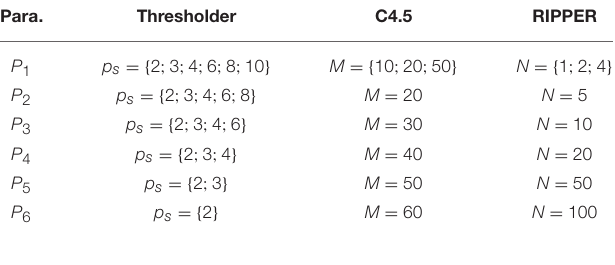
TABLE 4 | The six different generalization parameter sets used for evaluating the correlation between classification error and model size. Para. C4.5